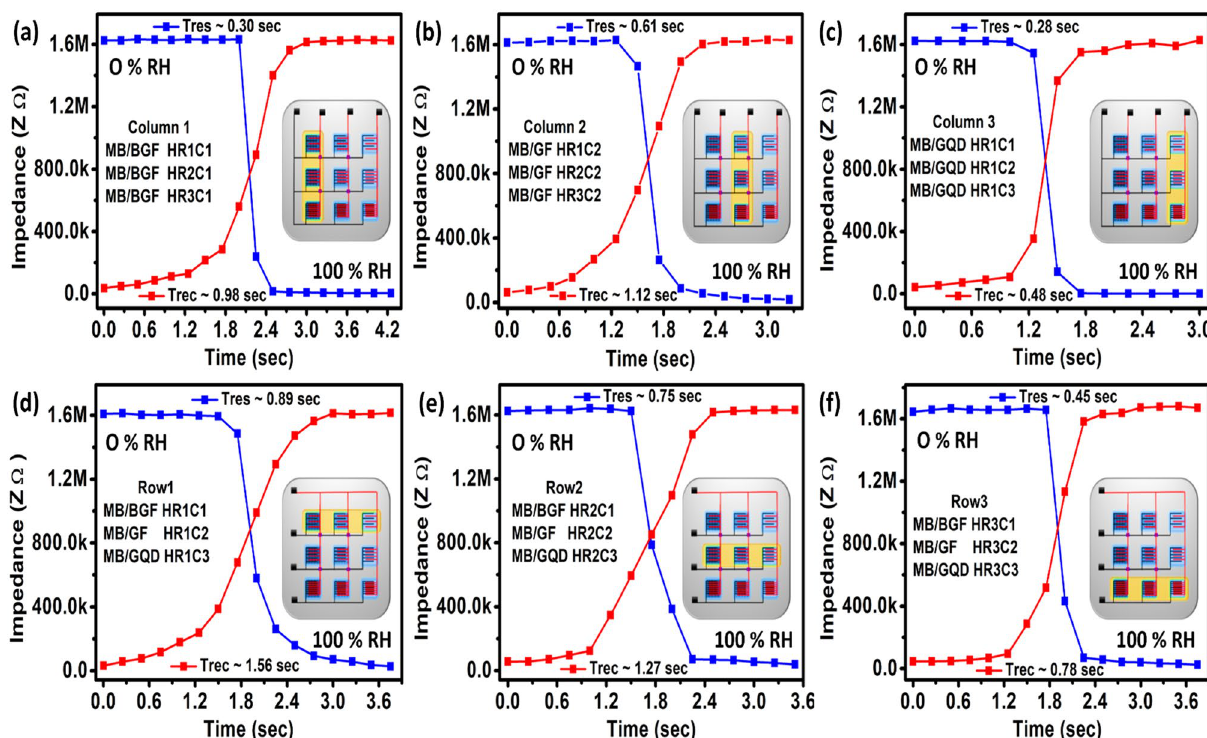
Figure 6. Transient response of ( a ) column 1, ( b ) column 2, ( c ) column 3, ( d ) row 1, ( e ) row 2, and ( f ) row 3.